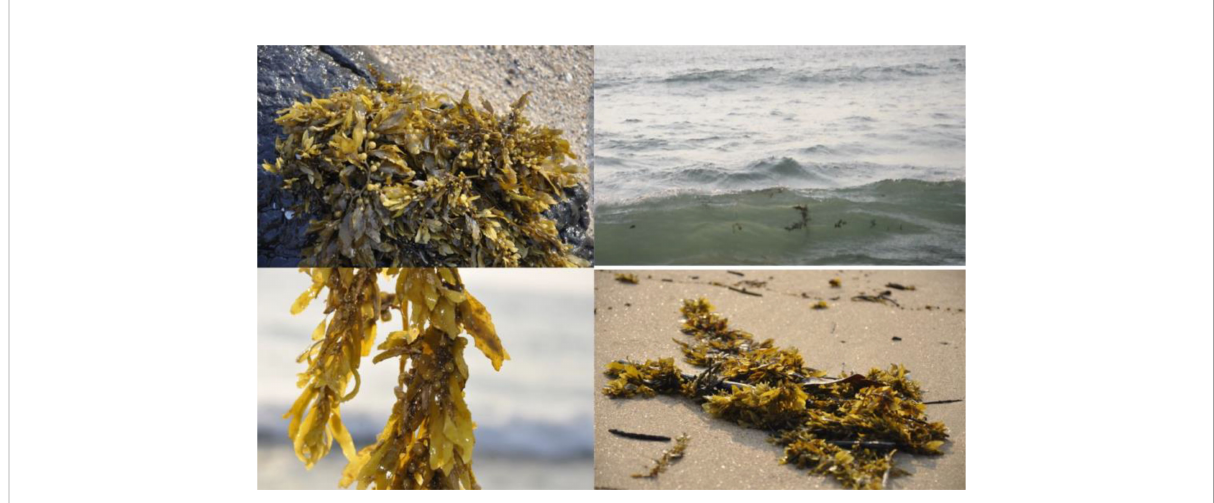
FIGURE 2 Plate no 2 plant material collected from sampling site.